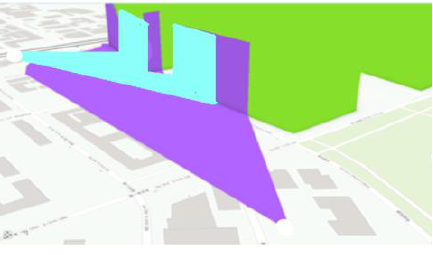
Figure 12 The coverage of multiple